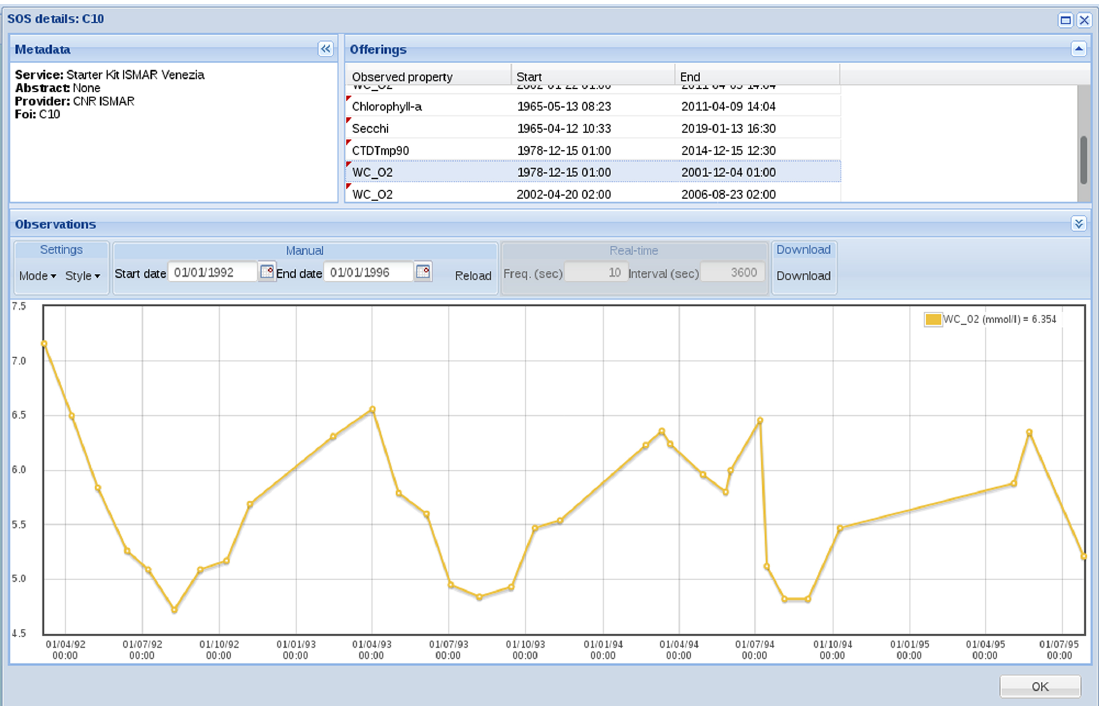
Figure 7. Example of the graph of output from a query into the PostGis (http://postgis.net/) database underlying the GET-IT platform Oxygen data at station C10 for the period 1 January 1992–1 January 1996 are